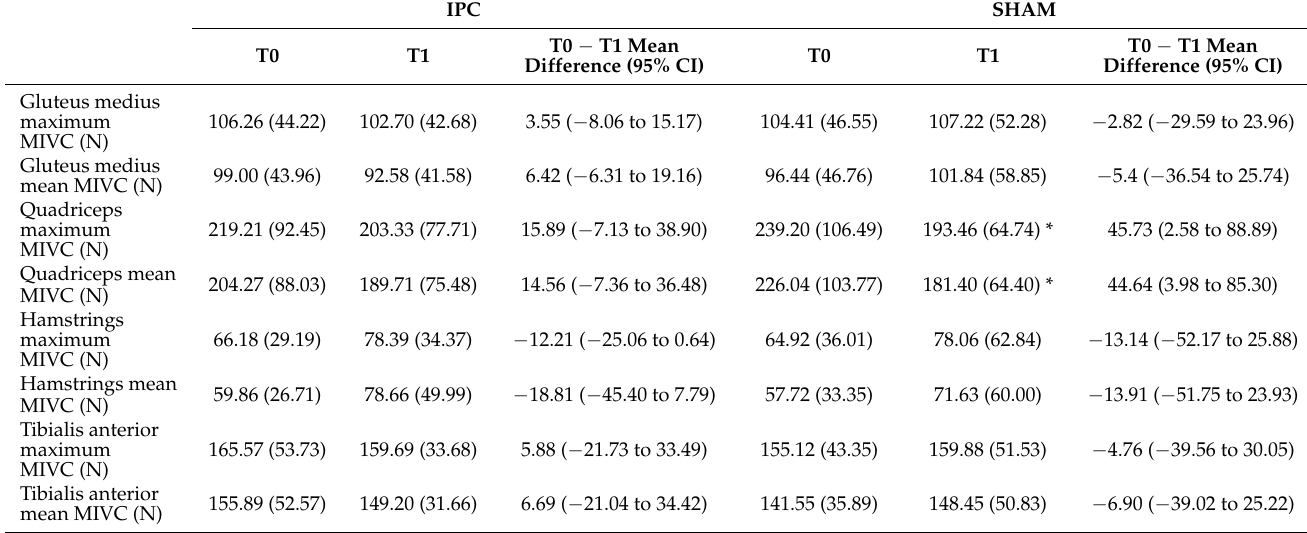
Table 2. Effect of the intervention on lower-limb MIVC, endurance performance, and perceived